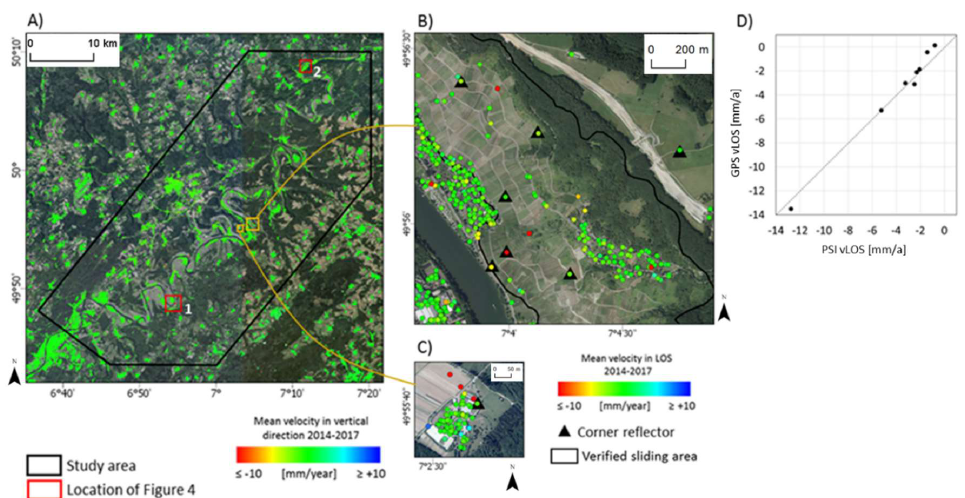
Interferometry (PSI) data. ( D ) Shows the result of the verification of the Sentinel-1 PSI Line-of-Sight (LOS) velocity, versus the Global Positioning System (GPS) velocity at the corner reflector